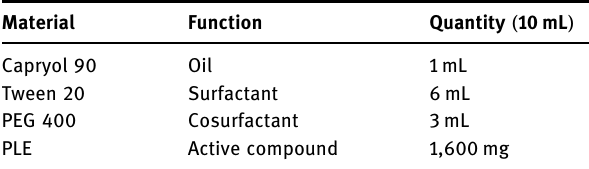
Table 1: SNEDDS formulation of PLE Material Function Quantity ( 10 mL